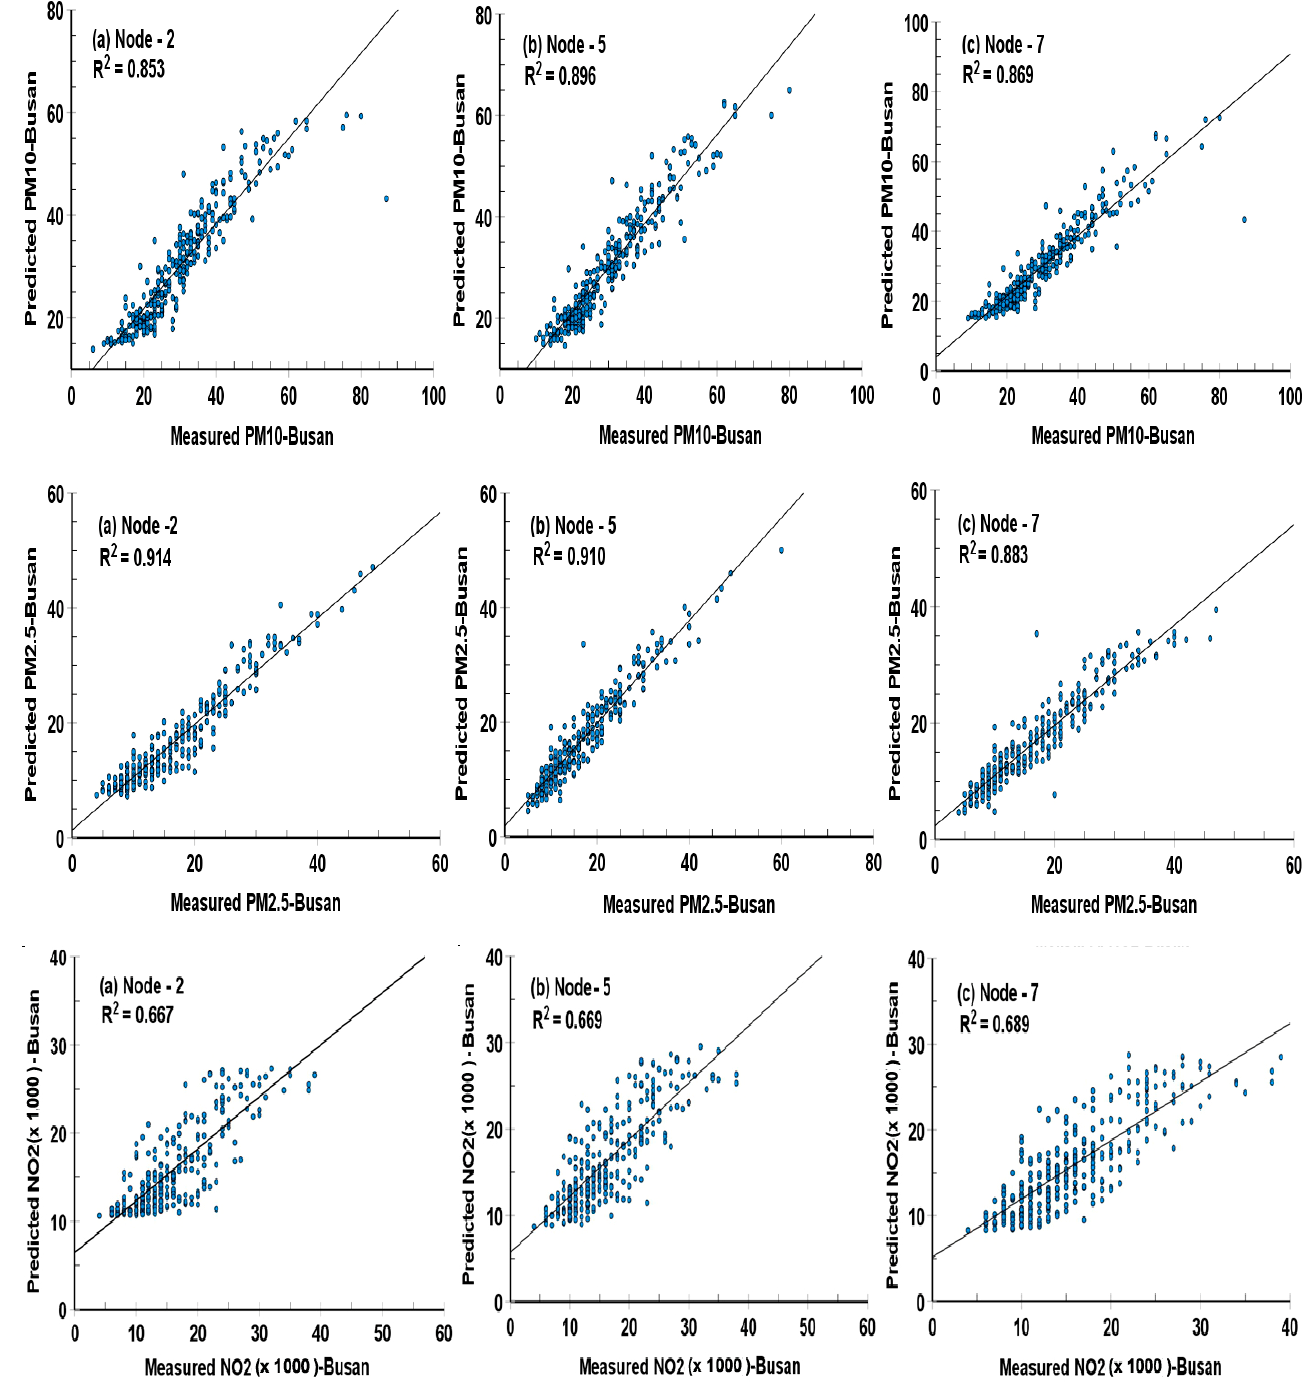
Figure 5. As shown in Figure 4, except for Busan city, Korea. The linear least-square method is employed to fit the empirical coefficients obtained for all variables by the ANN models. These scatter plots show that regardless of the number of nodes in the hidden layer, the correlation coefficients between the predicted and measured values had almost similar magnitudes. Among them, the highest correlation coefficients between the predicted and measured values of all variables were found in the five nodes of the hidden layer, except for the PM 2.5 (0.914 in 2 nodes) and NO 2 (0.689 in 7 nodes) variables in Busan city. Thus, overall, it can be said that the predicted values in the five nodes of the hidden layer are the best validated.